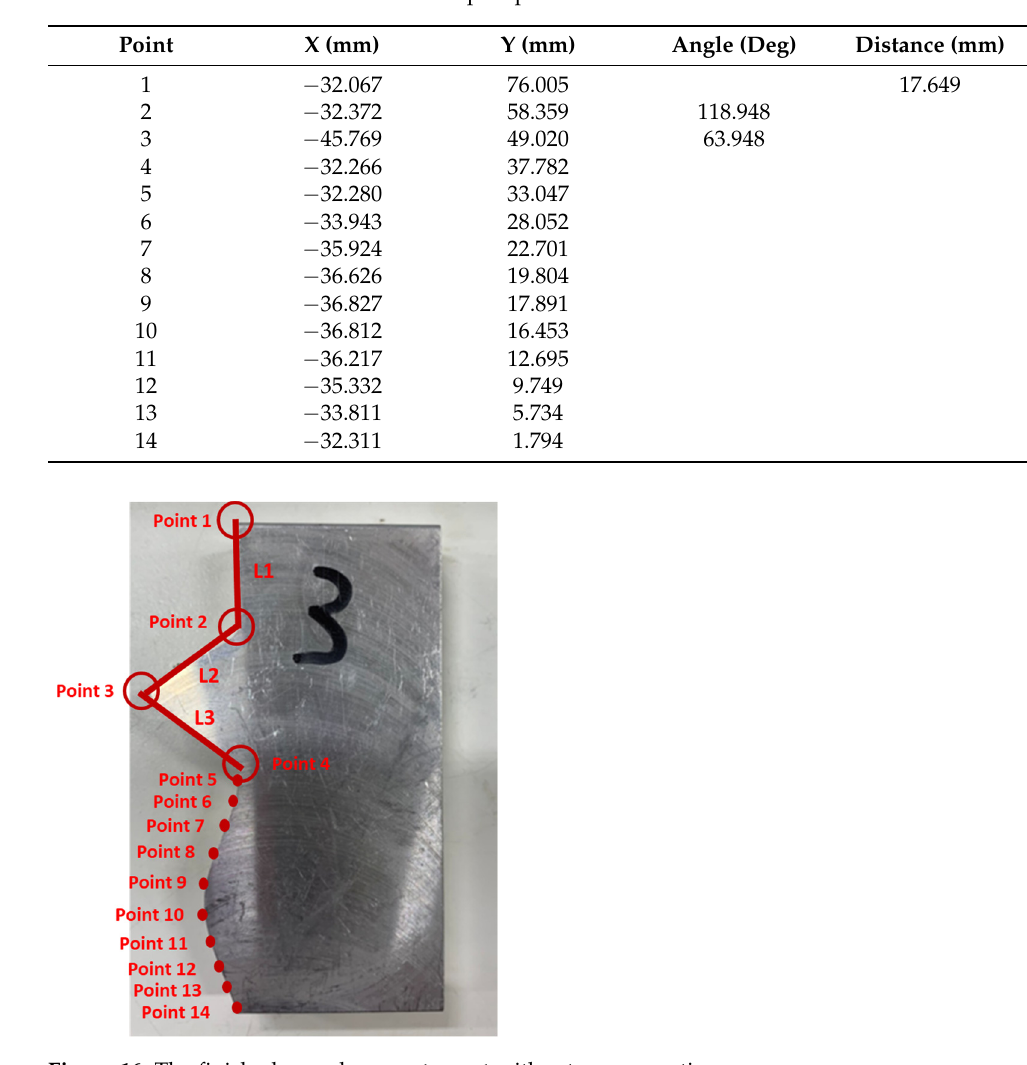
Figure 16. The finished complex counterpart without compensation.